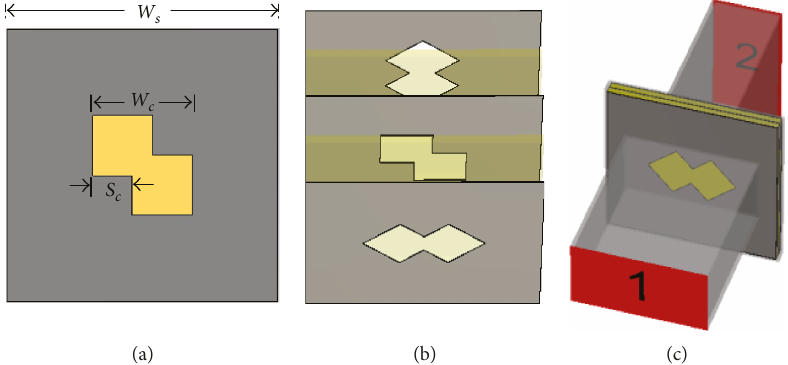
Figure 1: The proposed 90 ° waveguide twist. (a) Middle cladding layer with double-corner-cut square. (b) Three cladding layers with rotational double-corner-cut squares and two substrate layers. (c) Whole structure sketch.